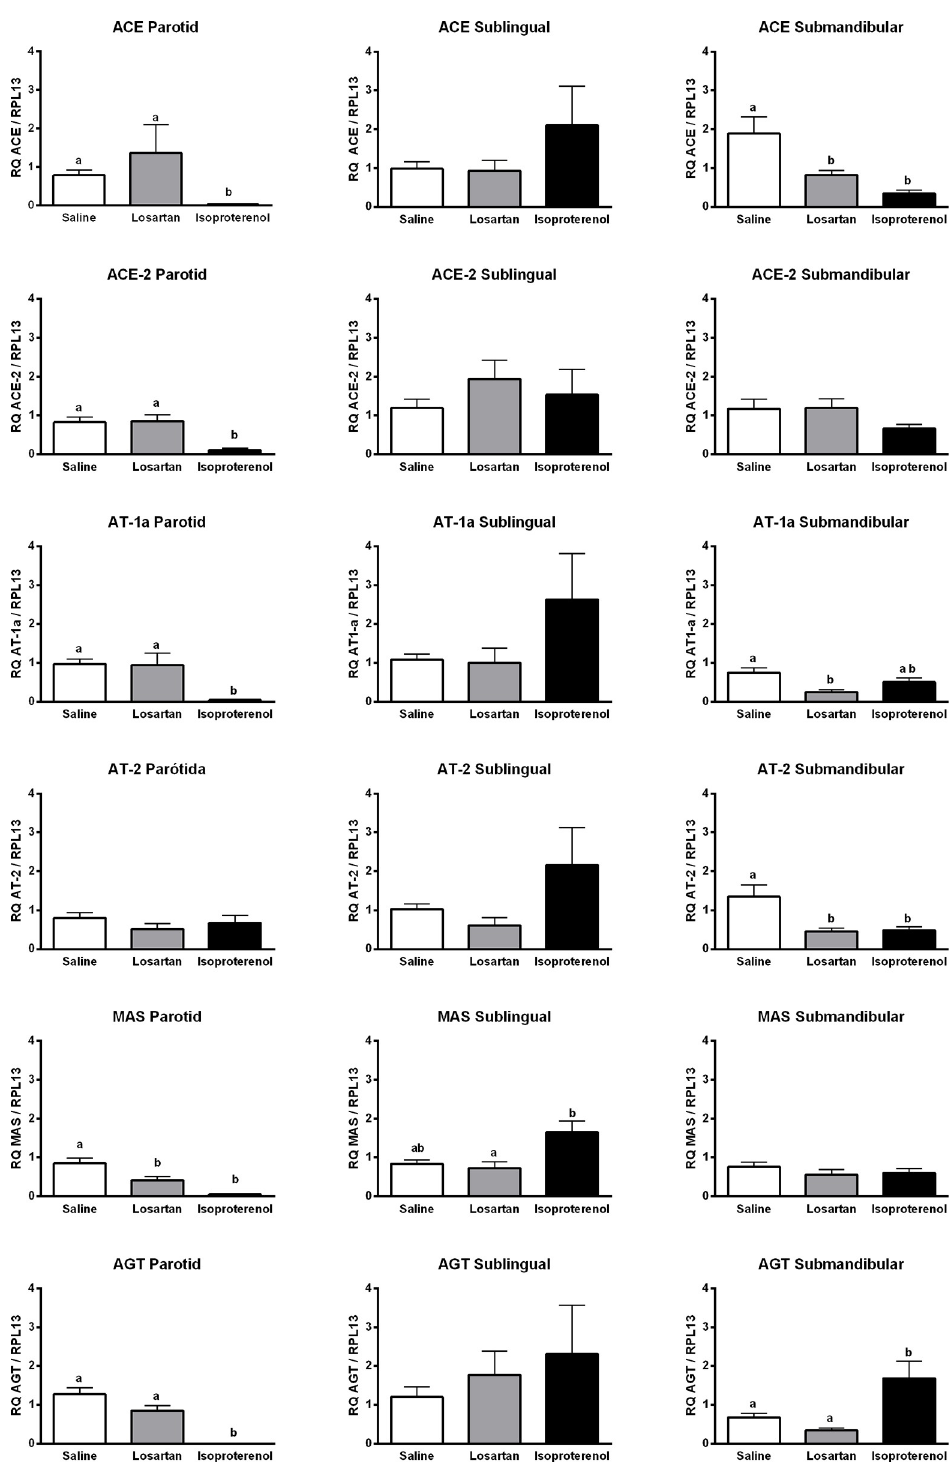
Fig 2. Relative quantification of each target in rat parotid, sublingual and submandibular glands. Data are means ± standard deviation. One-way ANOVA/Tukey’s multiple comparison tests were performed for parametric results whereas Kruskal-Wallis/ Dunn’s post-test was applied for non-parametric results. Differences were considered statistically significant when p < 0.05. Different letters indicate a statistically significant difference between groups and when such differences were calculated between two groups but not in a third one as compared to both, the latter is